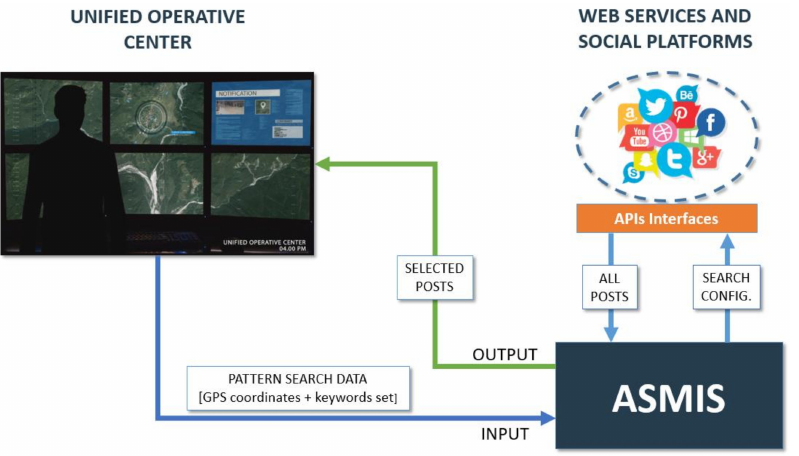
Figure 1. General overview of the ASMIS system for automatic analysis of visual content shared by users on Twitter during emergency